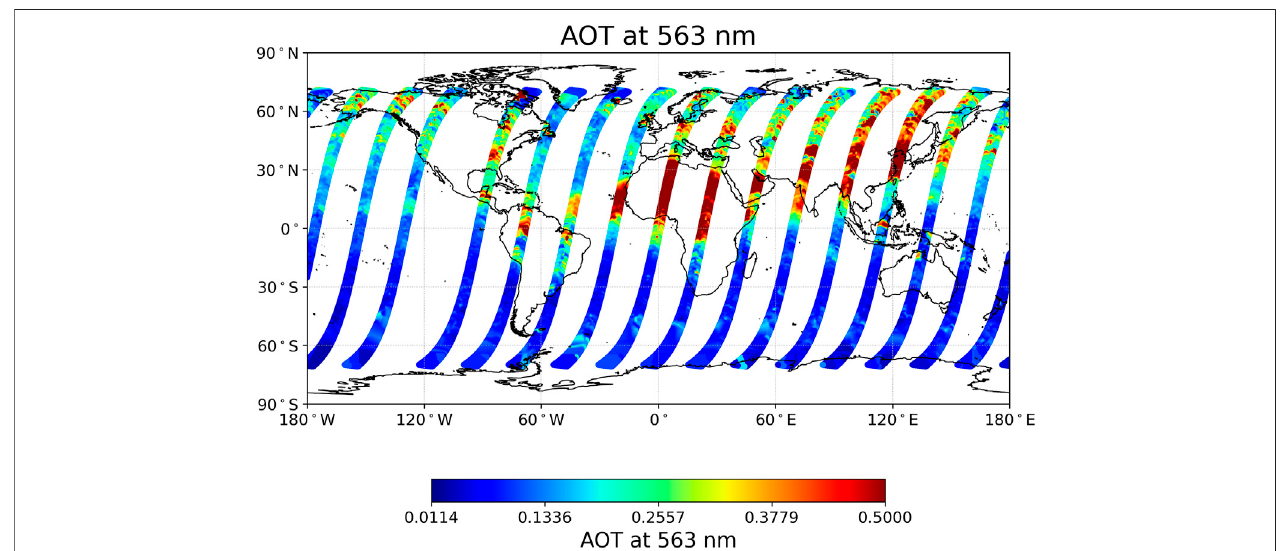
FIGURE 2 | Illustration of CO2M orbits showing the aerosol optical thickness at 563